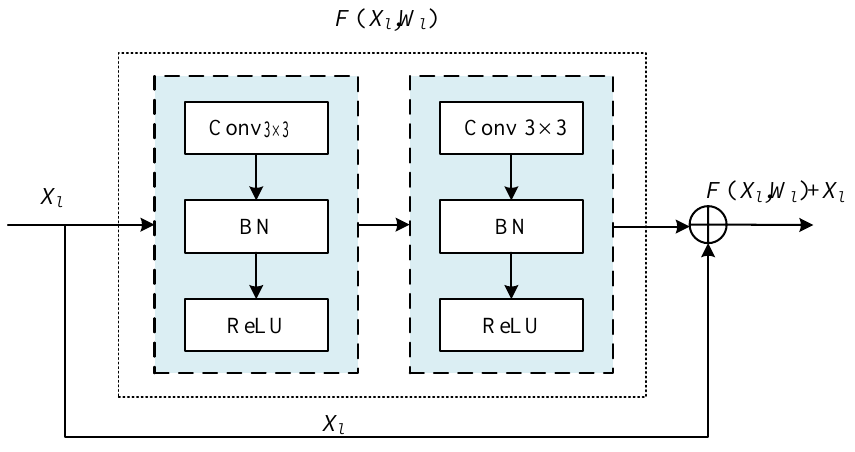
Figure 5. The architecture of the residual